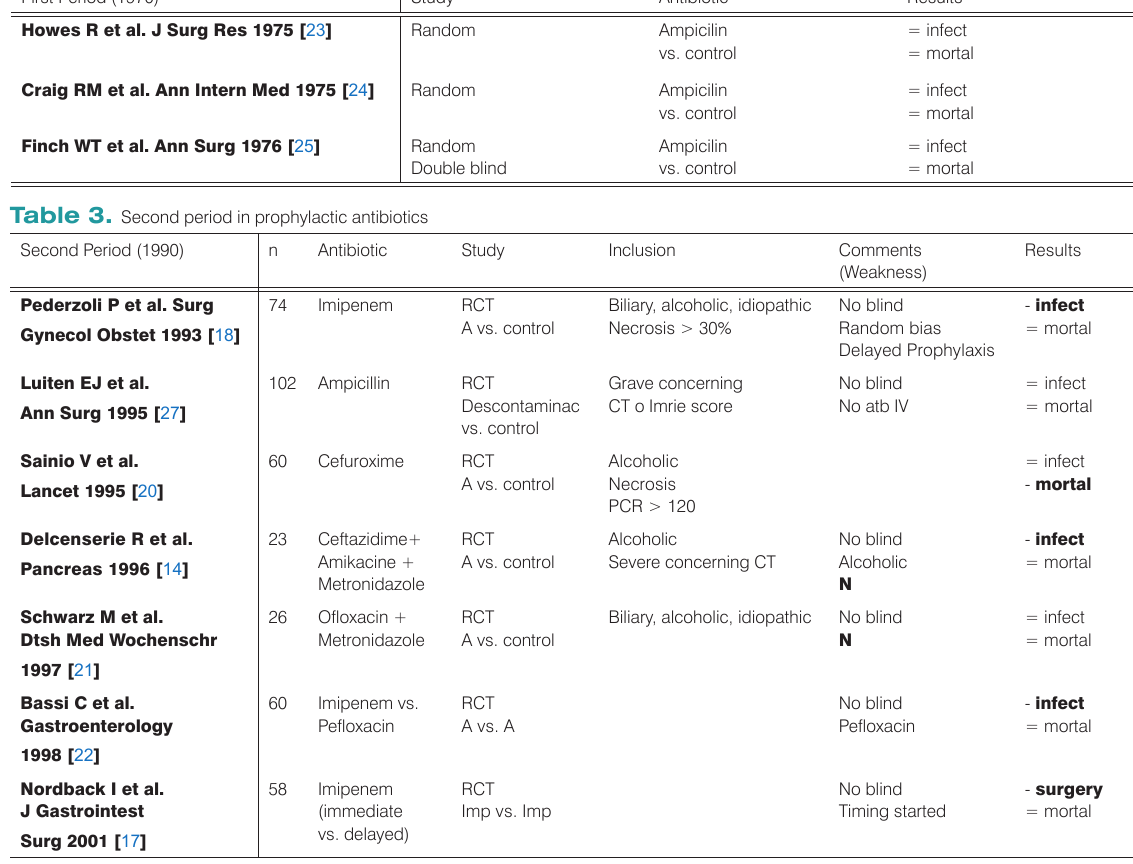
Table 2. First studies in prophylactic antibiotics